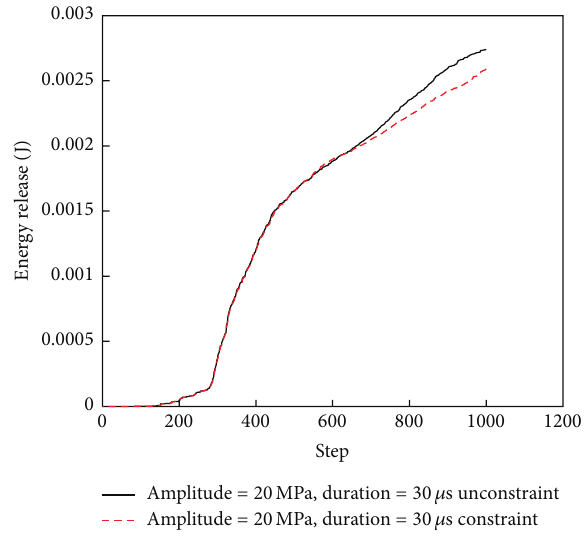
Figure 15: The damage energy release change rule of sample with unconstraint and